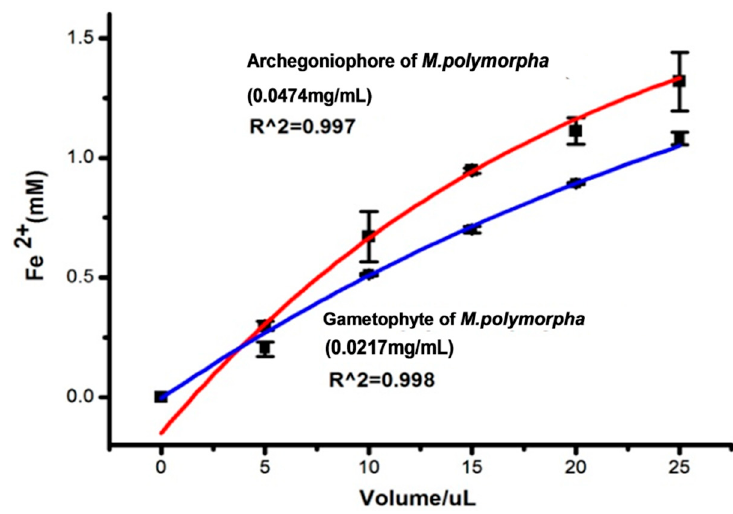
Figure 6. Antioxidant power by FRAP assay of archegoniophore and gametophyte of M. polymorpha ( n = 3).